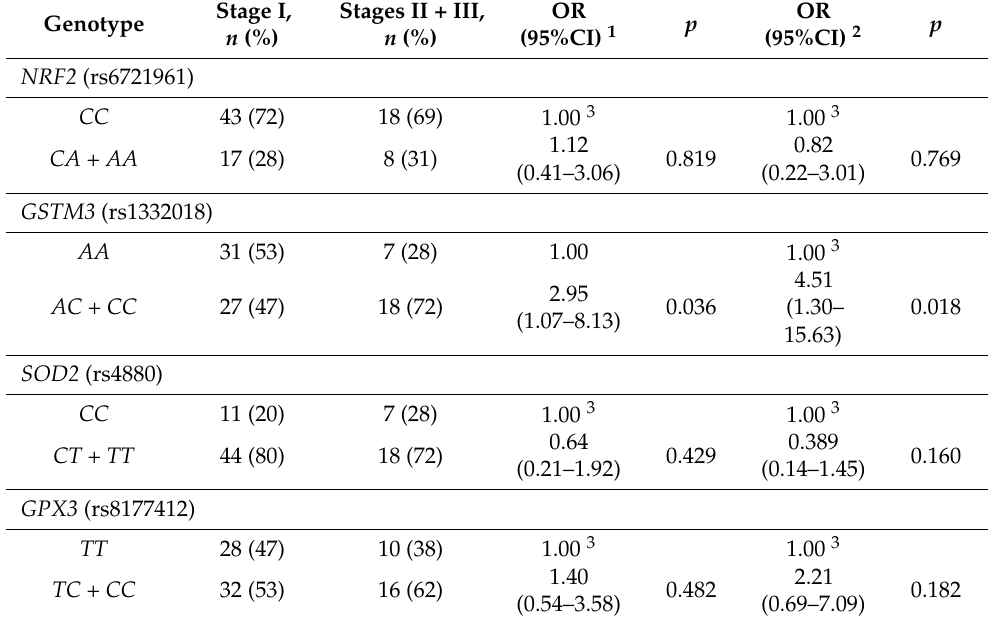
Table 5. The association between polymorphisms encoding for regulatory and catalytic antioxidant proteins with the risk of disease